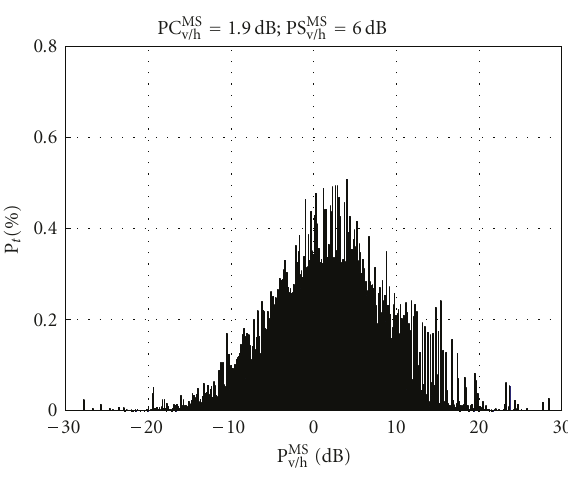
Figure 18: Normalized power distribution of P MS of the SCs, macrocell Rx19 to Rx27. XPR MS v